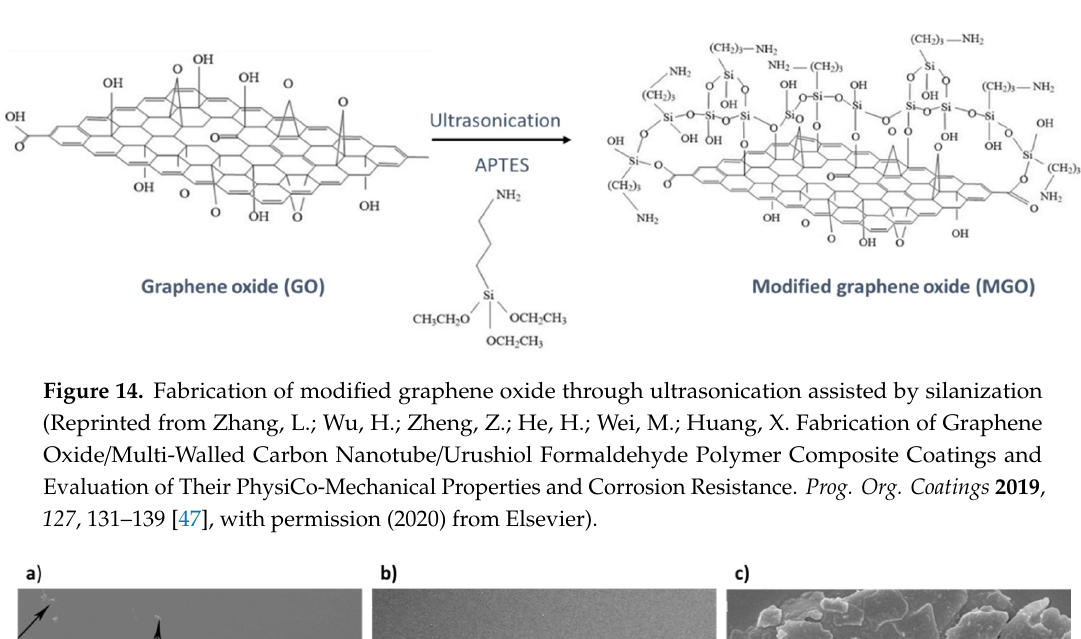
15 of 21 Figure 13. ( a ) SEM image of exfoliated graphene and the graphene/MWCNT/PS nanocomposites prepared by in situ micro-emulsion polymerization observed by ( b ) SEM and ( c ) TEM (adapted from [7]). Patole et al., used gel permeation chromatography (GPC) to evaluate the effect of binary fillers on two important polymerization parameters: molecular weight (MW) and the polydispersity index (PDI) of polystyrene. The results showed that the use of graphene and MWCNTs increased the molecular weight (~40,000 and ~65,000 g/mol for neat PS and nanocomposites, respectively) so that the binary fillers contributed to consuming the initiator. In this case, the quantity of the initiator diminished in the medium, which thus slowed down the formation of new polymer chains on the surface of the MWCNTs. Similarly, the PDI of the PS chains increased in the nanocomposites (~168,000 and ~228,000 for the neat PS and nanocomposites, respectively), because most of the PS nanoparticles were grafted to the MWCNTs and not to the graphene layers. Brownian motion is likely to have removed the absorbed surfactant SDS on the surface of the fillers, thus creating new active radical centers enabling the initiation of the polymerization reaction. Zhang et al. [47] fabricated anti-corrosion coating based on an urushiol formaldehyde polymer (UFP) in the presence of graphene oxide and multiwalled carbon nanotubes (GO/MWCNTs/UFP), which could be used in a marine environment. The two main steps consisted of in situ polymerization of UFP in the presence of MWCNTs followed by the incorporation of modified graphene oxide (MGO) in blending the MWCNTs/UFP. A mixture of urushiol and formaldehyde was prepared in xylene at 90 °C. Once the temperature dropped to 60 °C, an ultrasonicated treated solution of MWCNTs was added, producing MWCNTs/UFP (UFP to MWCNTs 100:1). The polymerization temperature ranged from 90 to 130 °C. FTIR analysis indicated that the in situ polymerization worked efficiently as a result of the decrease in the intensity of the characteristic peaks of O-H groups, proving the existence of chemical bonding between the OH groups from MWCNTs and the phenyl ring of the UFP. Then, an ultrasonicated-